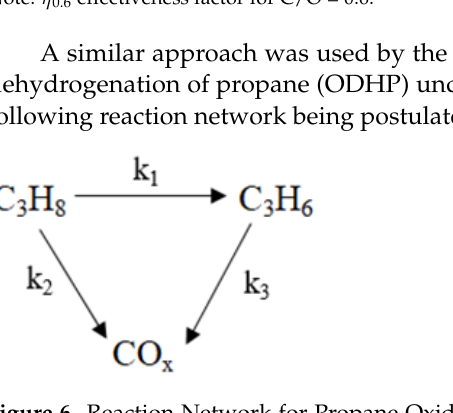
Table 3. Frequency Factors, Activation Energies and Estimated Operating Regimes at Various C/O Conditions [14].